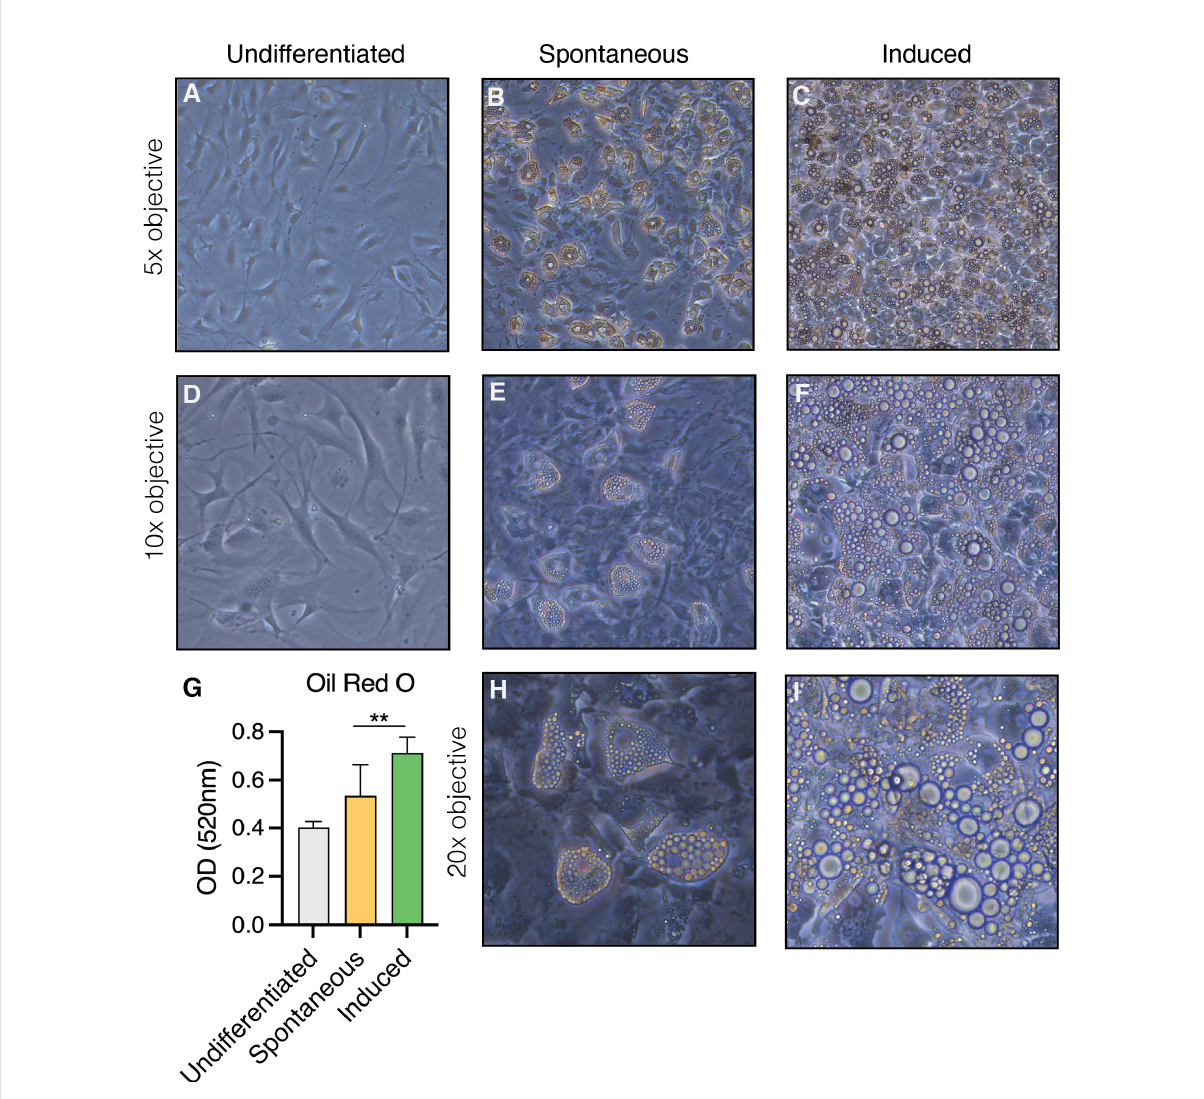
FIGURE 1 Heterogeneity in the formation of lipidated adipocytes upon induction of adipogenesis by con fl uency and serum exposure (spontaneous) versus DMI cocktail (induced). OP9 cells were (A – D) passaged subcon fl uently and remained undifferentiated on day 17 of culture, (B, E, H) differentiated spontaneously upon con fl uency in the presence of serum for 17 days, or (E, F, I) induced with a classical adipogenic differentiation cocktail in the same serum-containing conditions after con fl uent plating and 17 days in culture. (G) Oil red O measurements show the highest adipogenic differentiation in the induced condition at day 17 in culture. **P<0.01 by student ’ s t-test. Error bars represent mean ± s.d. (n = 3 biological replicates). DMI: 1µM dexamethasone, 0.5mM isobutyl-methylxanthine, 5µg/ml